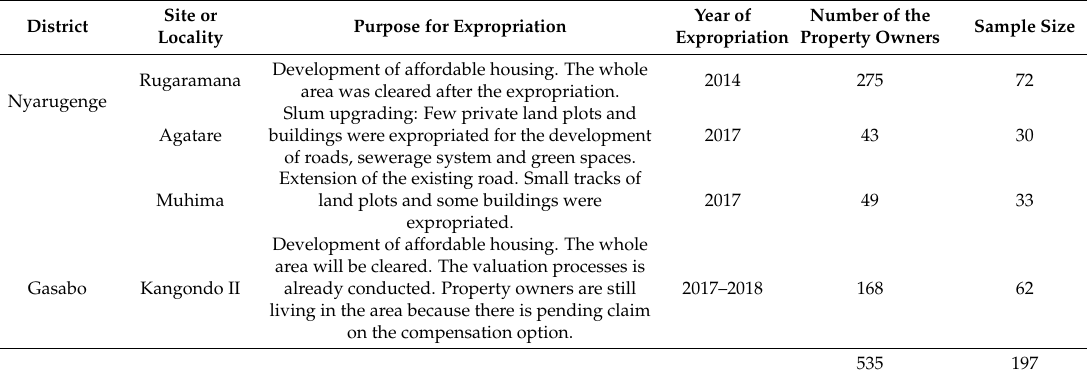
Table A2. Number of the households and sample sizes in the surveyed